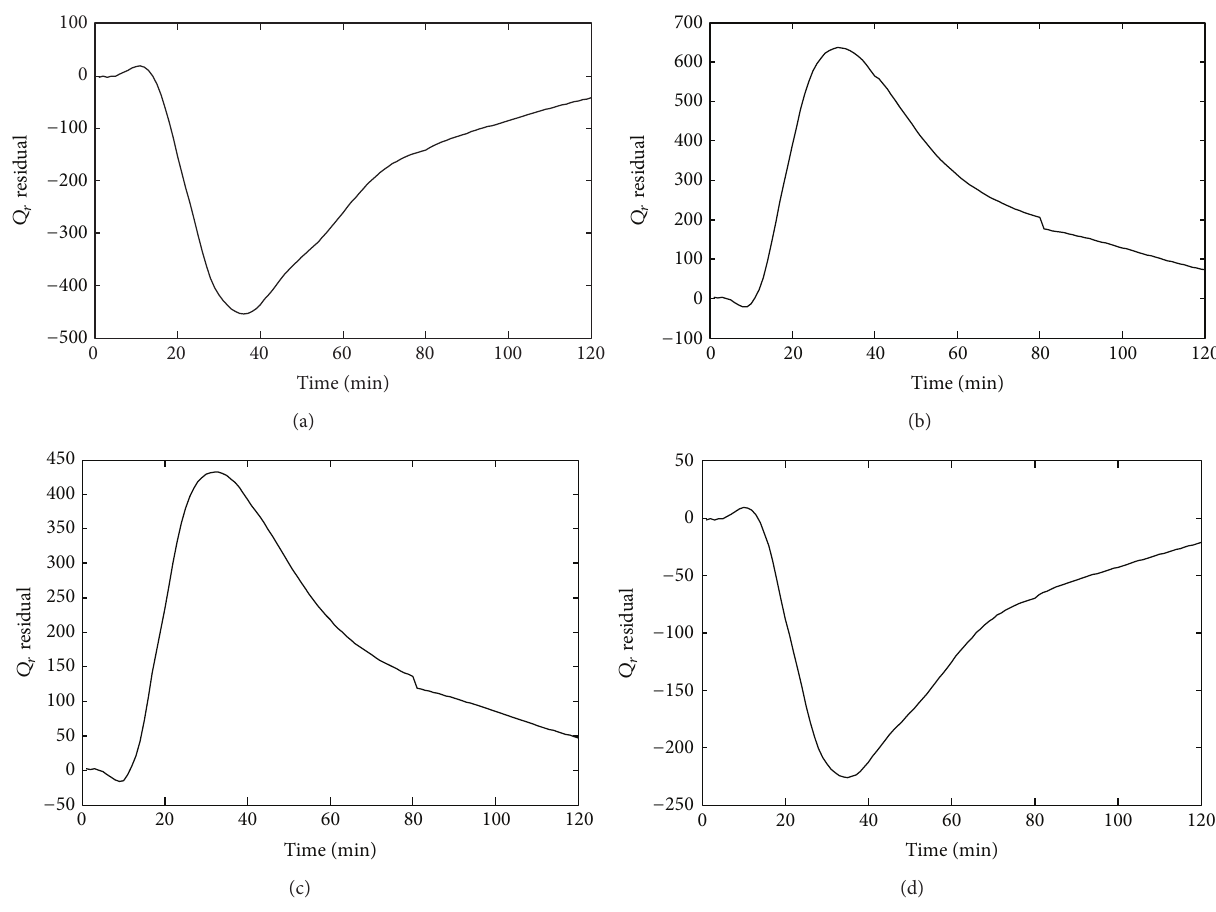
Figure 11: Residual (in terms of 𝑄 𝑟 ) due to change in initial values of the raw material ( 𝑀 𝐴 , 𝑀 𝐵 ). (a) Residual (in terms of 𝑄 𝑟 ) due to 25% increase in the initial values of the raw material ( 𝑀 𝐴 , 𝑀 𝐵 ). (b) Residual (in terms of 𝑄 𝑟 ) due to 30% decrease in the initial values of the raw material ( 𝑀 𝐴 , 𝑀 𝐵 ). (c) Residual (in terms of 𝑄 𝑟 ) due to 20% decrease in the initial values of the raw material ( 𝑀 𝐴 , 𝑀 𝐵 ). (d) Residual (in terms of 𝑄 𝑟 ) due to 10% decrease in the initial values of the raw material ( 𝑀 𝐴 , 𝑀 𝐵 ). Table 6: Results for training of fault